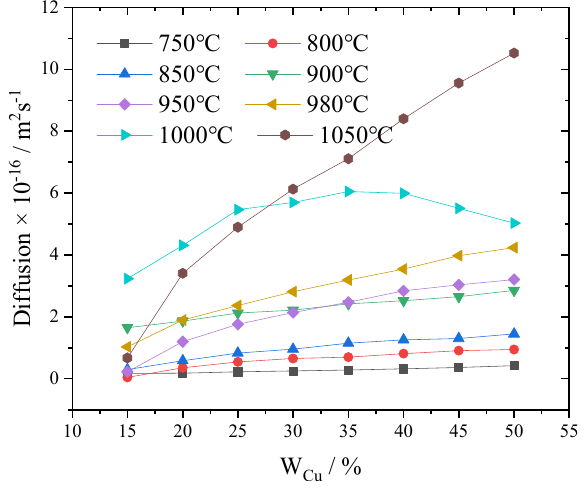
Figure 7. The relationship between the diffusion coefficient of Cu in low-carbon steel and the mass concentration of Cu at different diffusion annealing temperatures.